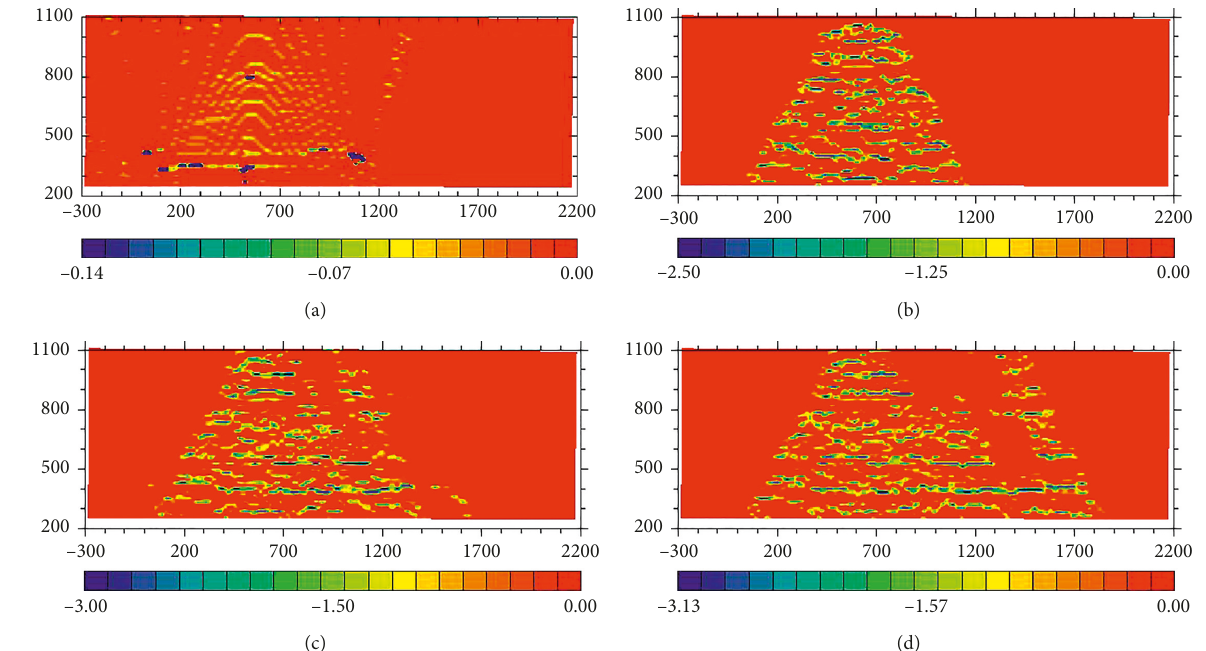
Figure 10: The distribution of vertical strain during excavation. The coal stratum is excavated to (a) 120m, (b) 130m, (c) 165m, and (d)